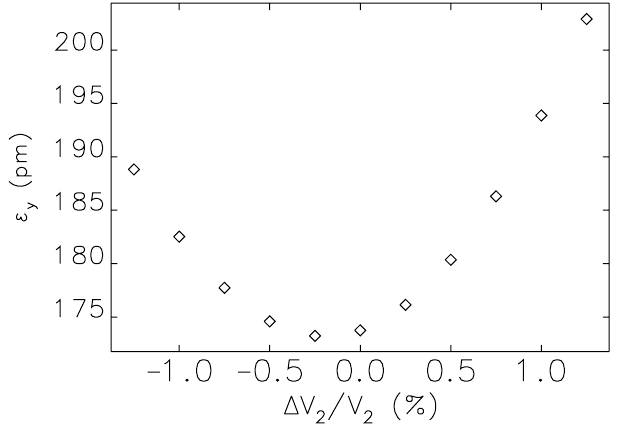
4 MV with voltage error in the second